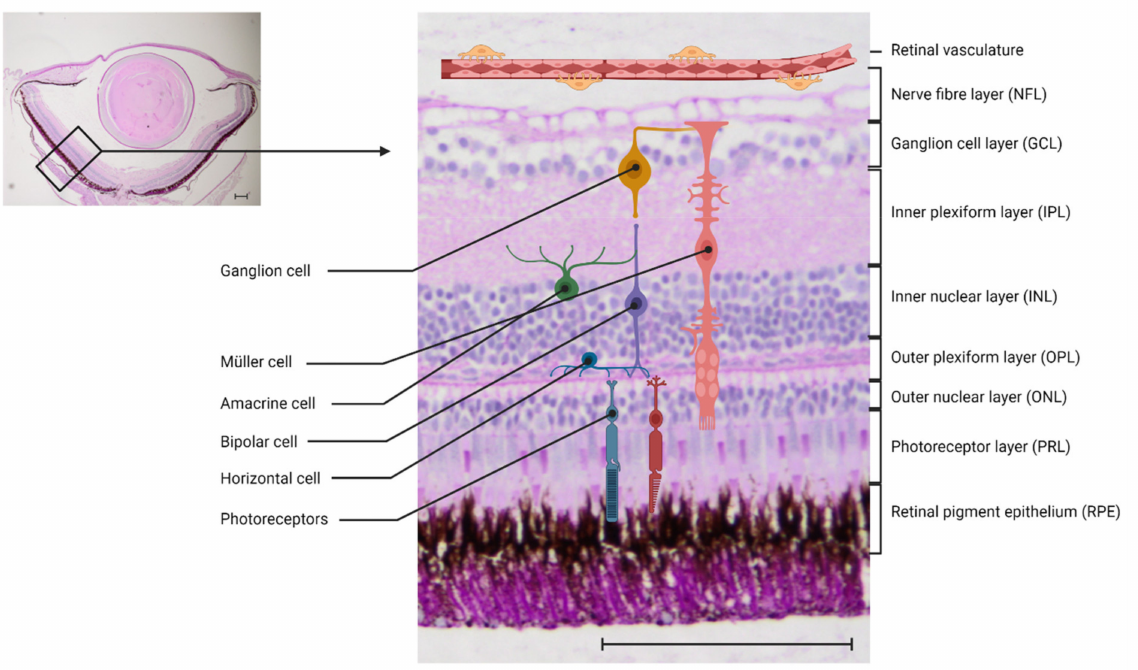
Figure 1. Anatomy of the zebrafish retina: Left: 4 × magnification of a paraffin cut of the zebrafish retina, periodic-acid Schiff’s (PAS) stain. Right: 20 × magnification of the zebrafish retina with a schematic overview of the different cell types. Scale bar = 100 µ